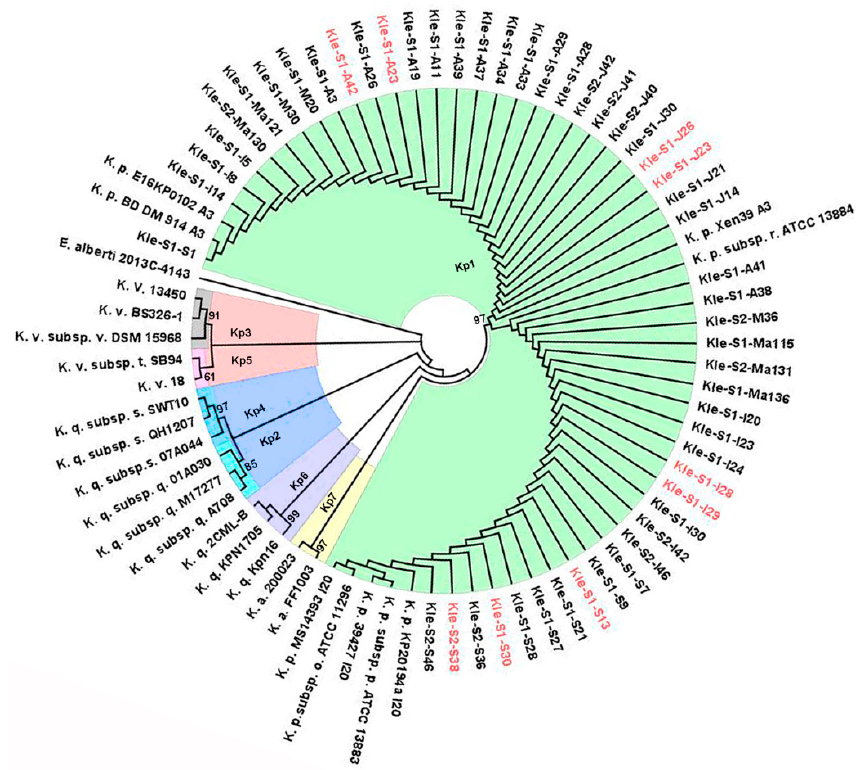
Figure 1. Neighbor Joining tree built on partial dna J sequences. Bootstrap values (>60%) are shown adjacent to each Klebsiella phylogroup. The annotations of the GenBank taxa were abbreviated as follows: K. pneumoniae (K. p.), K. pneumoniae subsp. pneumoniae (K. p. subsp. p), K. pneumoniae subsp.